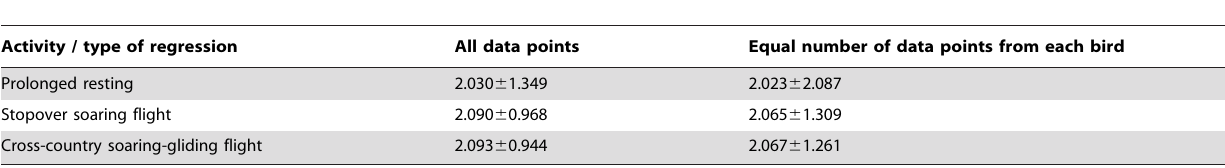
Table 3. Estimated (average 6 SEE) _ VV O 2 of European bee-eaters during prolonged resting, stopover soaring, and cross-country soaring-gliding